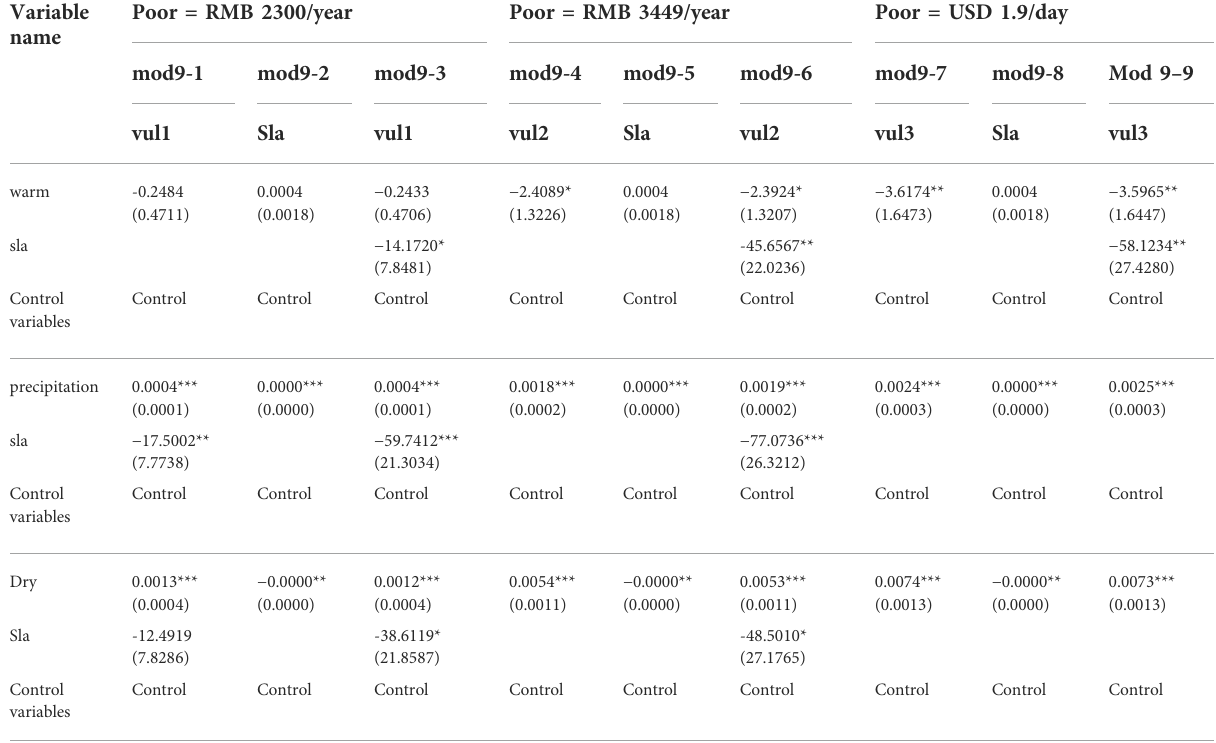
TABLE 9 Test results of mediating effects of sustainable livelihood capacity of farm households under different poverty line